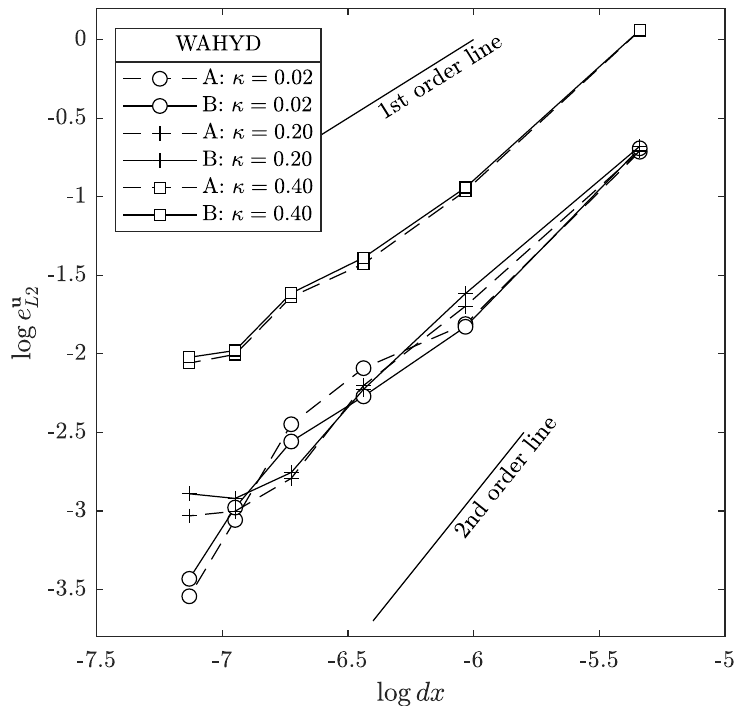
Figure 14. Velocity L 2 error norm as function of the interpolation schemes and κ parameter for the flow between concentric cylinders case using the WAHYD method.